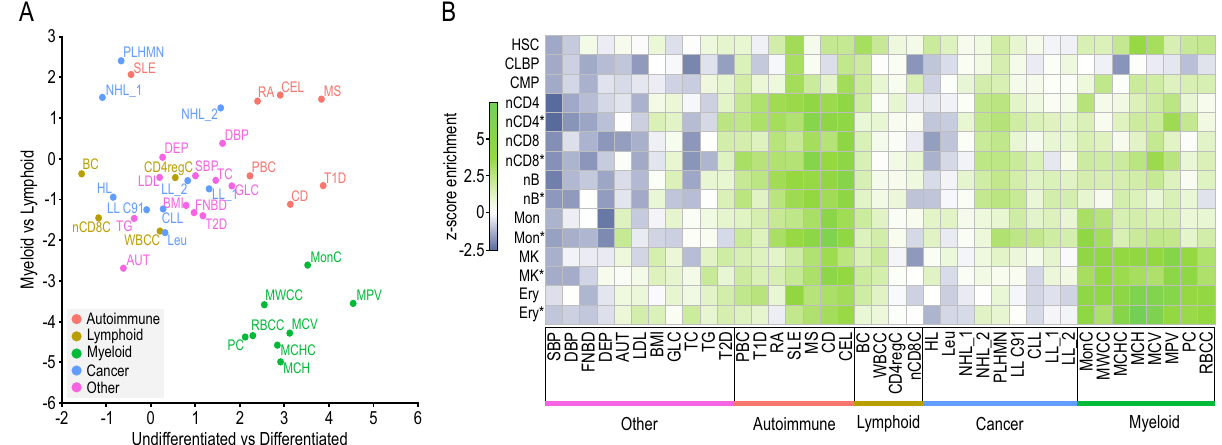
Fig. 4 | liCHi-C identi fi es cell types presumably implicated in disease etiology. A Enrichment of GWAS summary statistics at promoter-interacting regions (PIRs) by cell type. Axes re fl ect Blockshifter z-scores for two different tissue group com- parisons: myeloid versus lymphoid ( y axis) and undifferentiated against differ- entiated cells ( x axis). Traits are labeled and colored by category: autoimmune disorder (red), lymphoid trait (yellow), myeloid trait (green), blood cancer (blue), and other (purple). SBP systolic blood pressure, DBP diastolic blood pressure, FNBD femoral neck bone mineral density, DEP depression, AUT autism, LDL low- density lipoprotein, BMI body mass index, GLC glucose sensitivity, TC total cho- lesterol, TG triglycerides, T2D type II diabetes, PBC primary biliary cirrhosis, T1D type I diabetes, RA rheumatoid arthritis, SLE systemic lupus erythematosus, MS multiplesclerosis,CDCrohn ’ sdisease,CELceliacdisease,BCB-cellabsolutecount, WBCC white blood cell count, CD4regC CD4 regulatory T-cell absolute count, nCD8C naive CD8 + T-cell absolute count, HL Hodgkins lymphoma, Leu leukemia, NHL_1 non-Hodgkins lymphoma_1, NHL_2 non-Hodgkins lymphoma_2, PLHMN